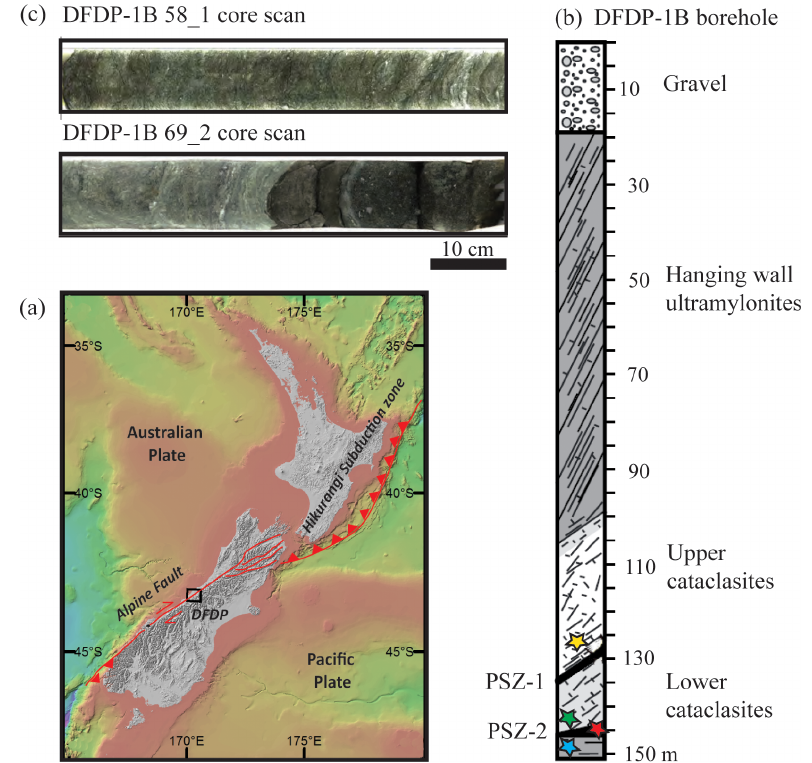
Figure 1. (a) Location map of DFDP drill sites (a bathymetric map compiled by NIWA, the National Institute of Water and Atmospheric Research). Drill site coordinates: 43 ◦ 17 (cid:48) 5 (cid:48)(cid:48) S, 170 ◦ 24 (cid:48) 22 (cid:48)(cid:48) E. (b) Schematic diagram of the sampled lithologies in DFDP-1B borehole (mod- ified after Sutherland et al., 2012). (c) Scans of DFDP-1B drill core. Samples were collected from the locations indicated with stars: